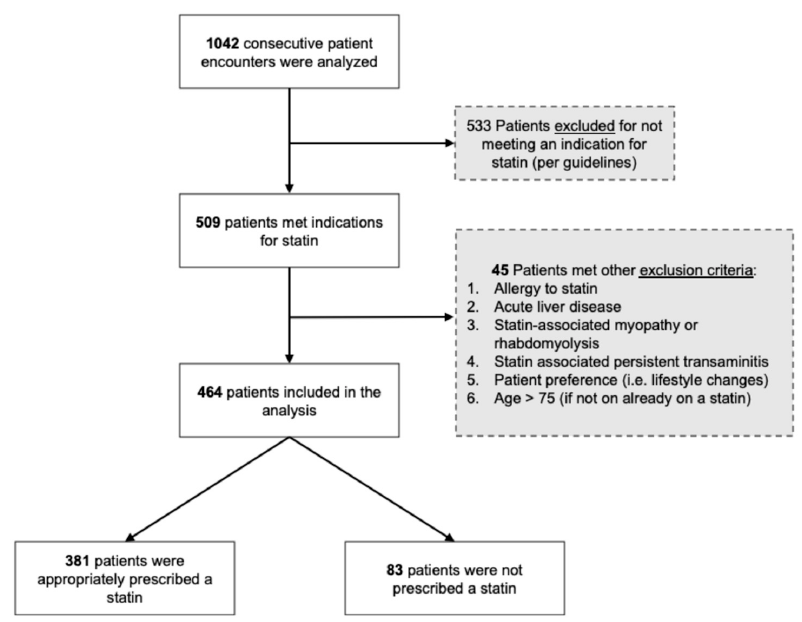
Figure 1. Flow diagram with patient selection and study criteria.